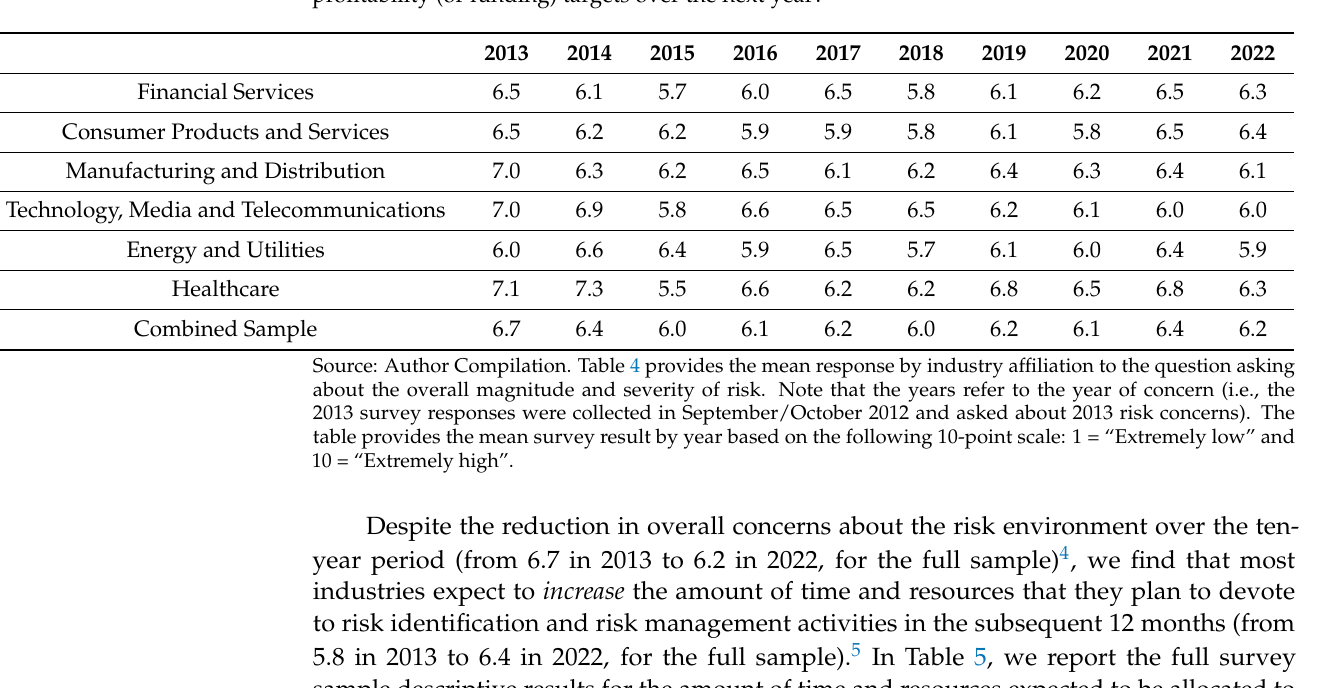
Table 4. Overall Assessment of the Risk Environment. Survey Question: What is your perception of the magnitude and severity of risks your entity will confront with respect to reaching or exceeding profitability (or funding) targets over the next year?